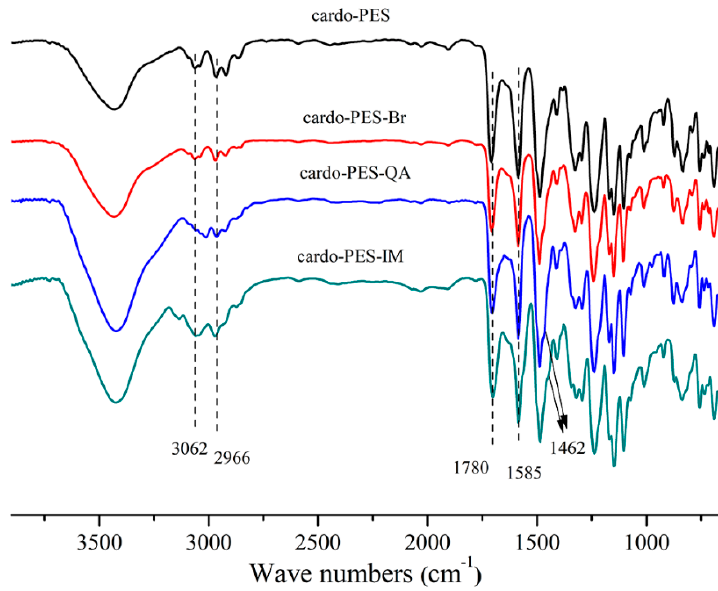
Figure 4. FT-IR spectra of the multiblock copolymers.